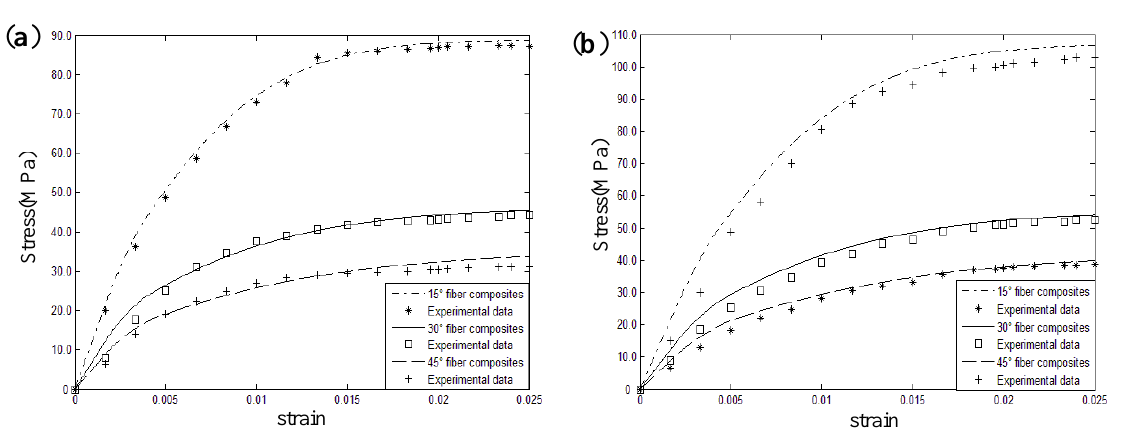
Figure 9. Experimental research on polymer-matrix composites: ( a ) Strain rate 0.00001/s. ( b ) Strain rate